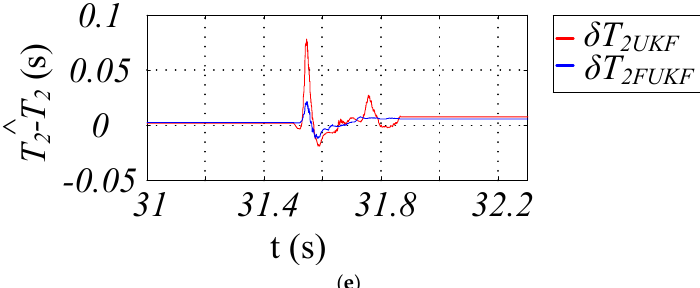
Figure 5. Comparative analysis of the estimation errors for the UKF and FUKF: the motor angular speed ( a ), the load angular speed ( b ), the mechanical shaft torque ( c ), the mechanical load torque ( d ), and the load time-constant of the machine ( e ).